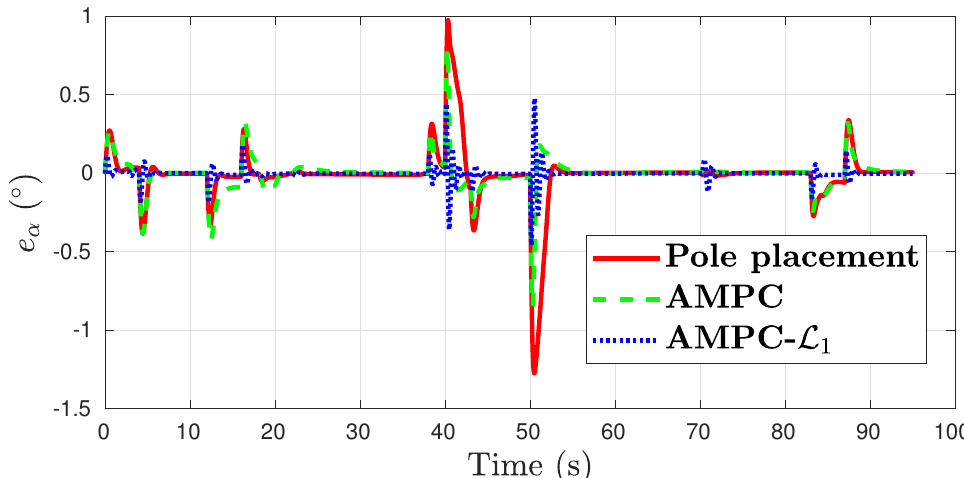
Figure 12. Angle-of-attack tracking error for guidance uncertainty case.